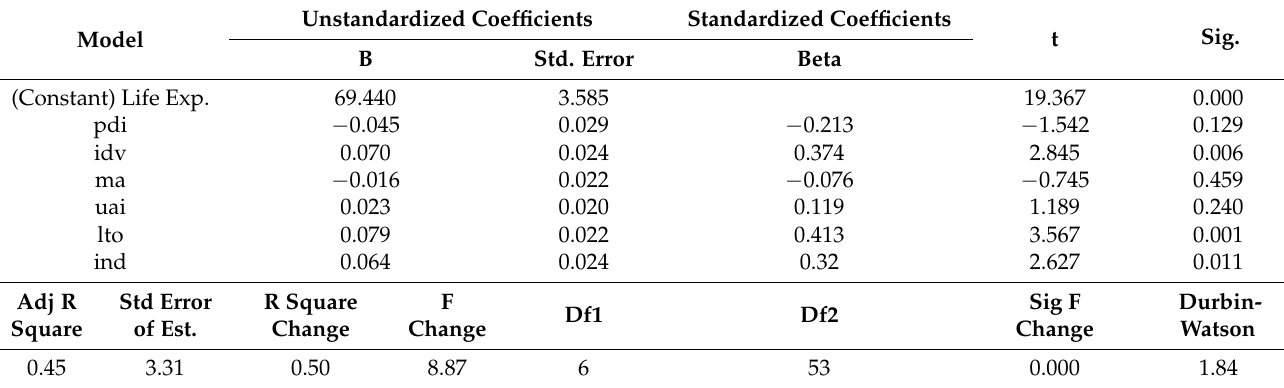
Table 2. Life Expectancy Model 1: Regression results.